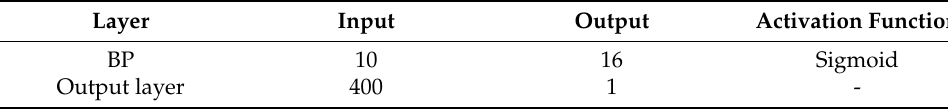
Table 8. Layer architecture of BP and Output layer.